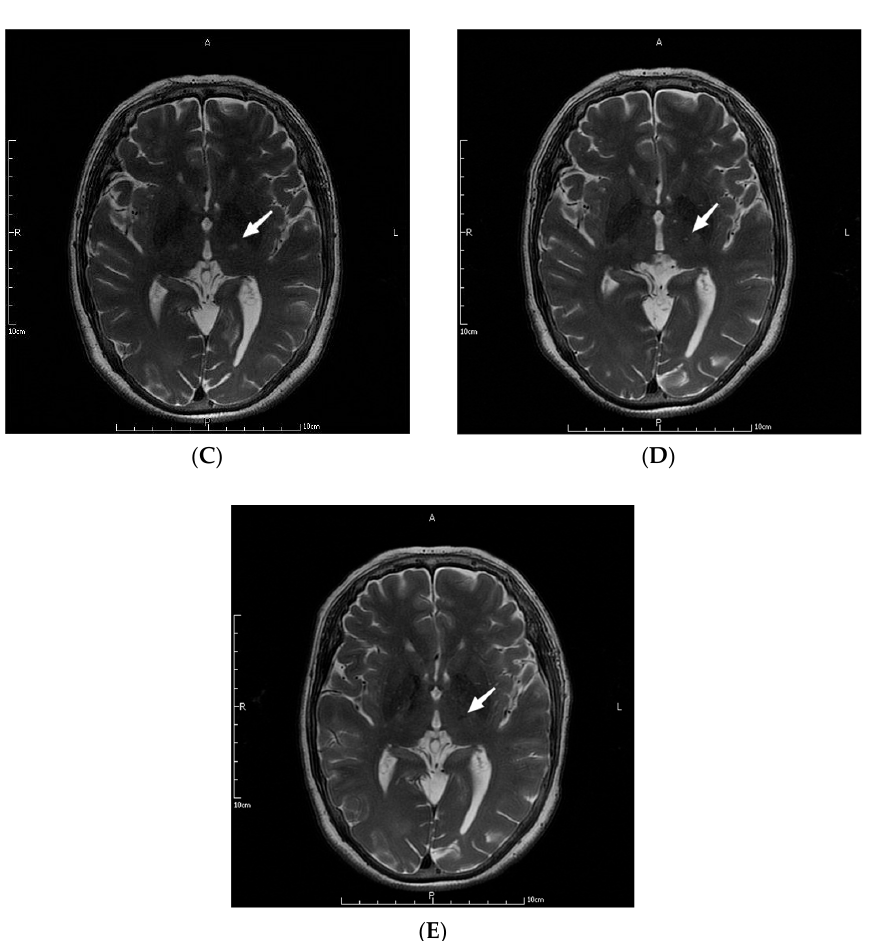
Figure 1. MRI images of a patient before ( A ), during ( B ), and at one month ( C ), three months ( D ), and one year ( E ) after the operation. The letters in the pictures are abbreviations of anterior (A), posterior (P), left (L) and right (R). The white arrow pointed to the lesions created by MRgFUS Vim